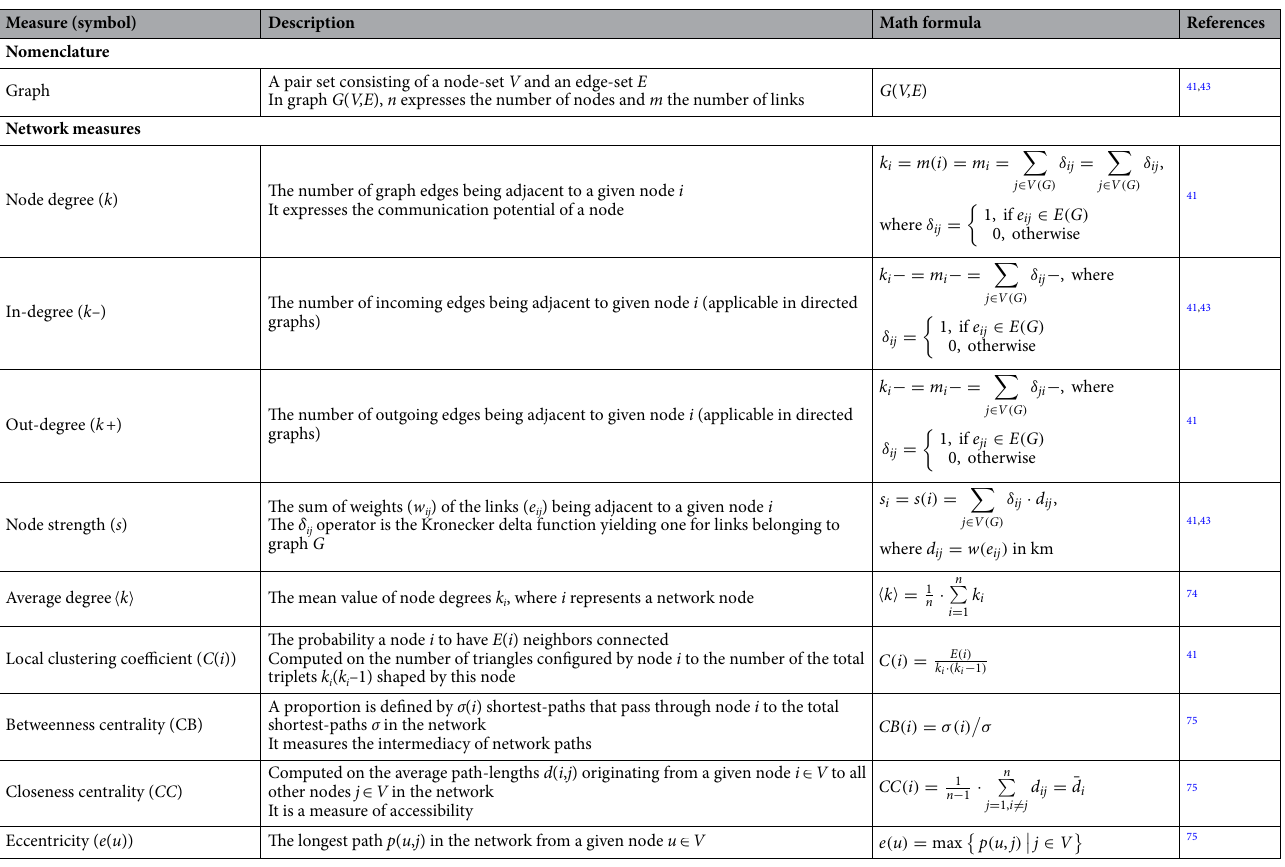
Table 1. Measures of network topology used in the analysis of